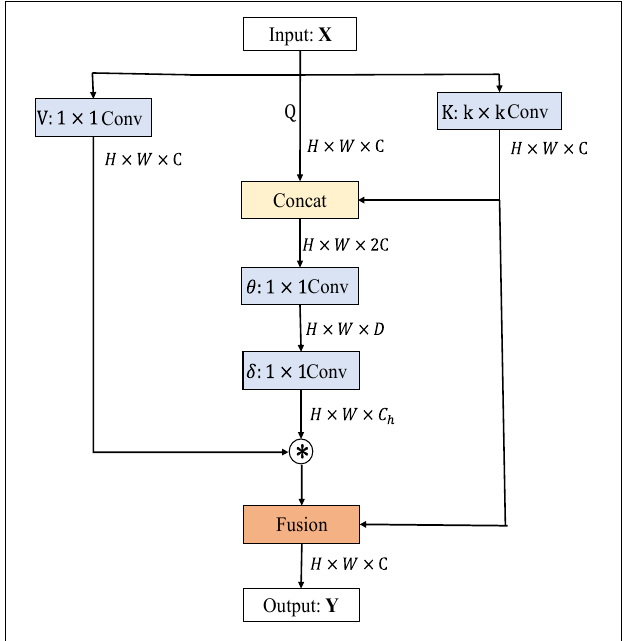
FIGURE 1 | Contextual Transformer (CoT) block